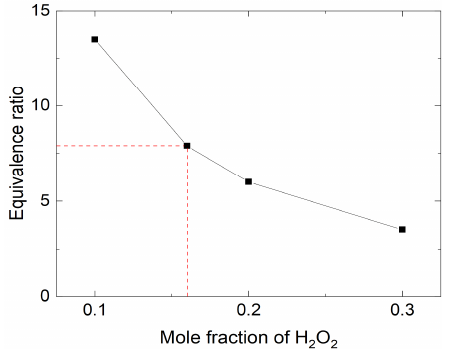
Figure 5. NH 3 and O 2 ( a ), as well as H 2 O 2 ( b ), mole fraction distributions along the burner center line.